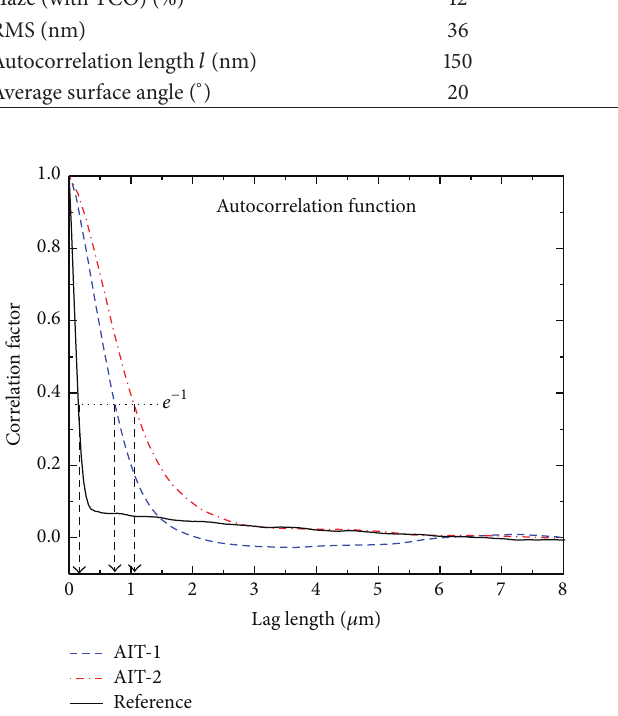
Figure 3: Surface angle distribution for the three different super- strates used.